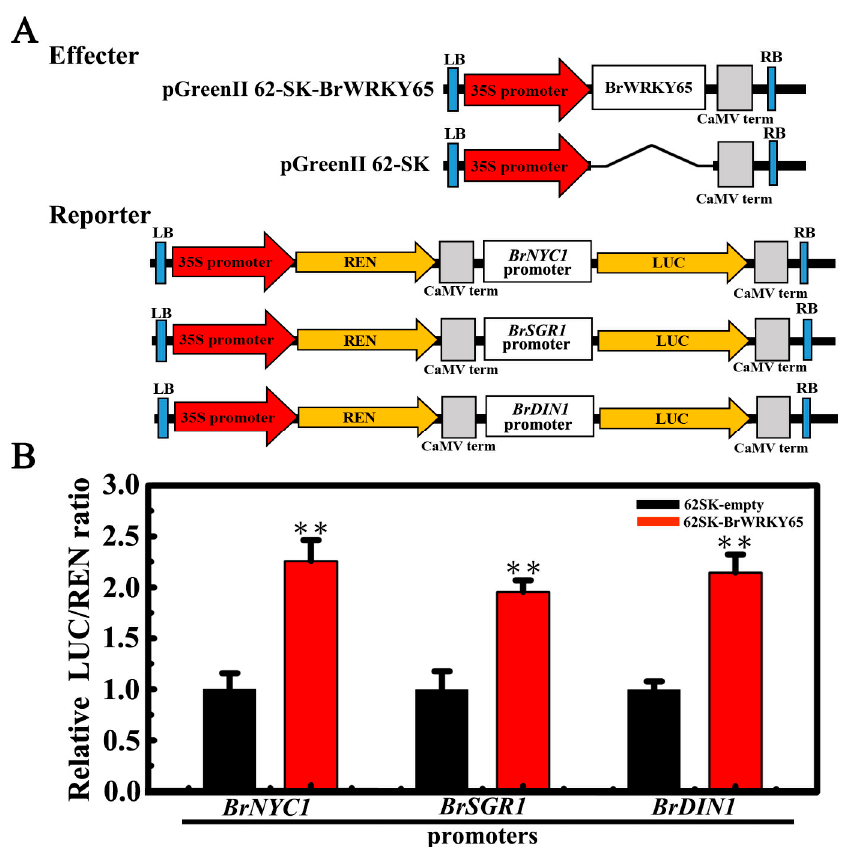
Figure 6. Transient dual-luciferase reporter assay showing the trans-activation of BrNYC1 , BrSGR1 , and BrDIN1 by BrWRKY65. ( A ) Diagrams of the reporter and effector constructs; ( B ) BrWRKY65 trans-activated BrNYC1 , BrSGR1 , and BrDIN1 promoters. The ratio of LUC/REN of the empty vector (62-SK) plus promoter was considered as a calibrator (set as 1). The activation is indicated by the ratio of LUC to REN. Data represents the mean ± S.E. of six independent repeats. ** indicates statistically significant differences at the level of p < 0.01 tested by Student’s t -test.